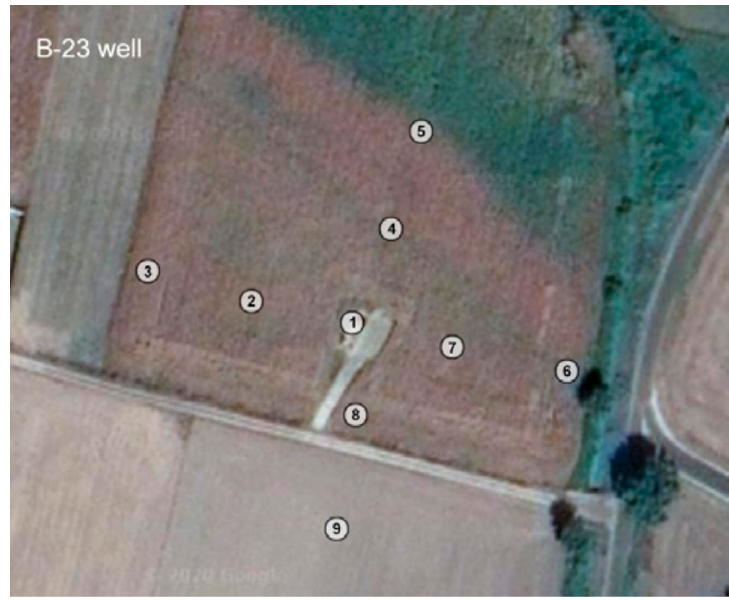
Figure 12. Location of measuring points around the B-23 well.